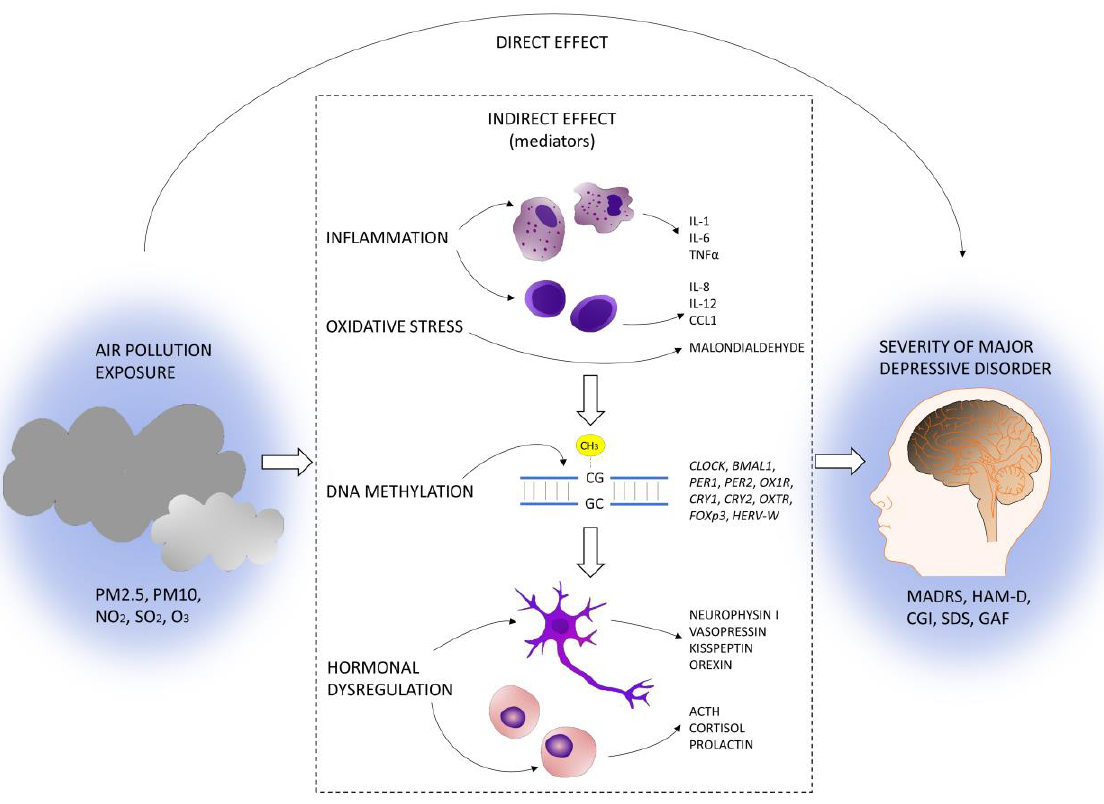
Figure 1. DeprAir conceptual framework.